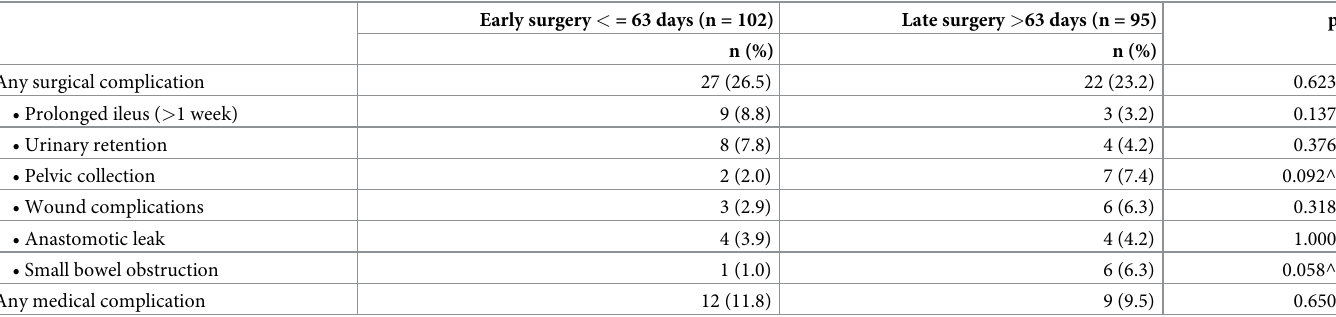
Table 3. Complication rates comparing early and late surgery groups.